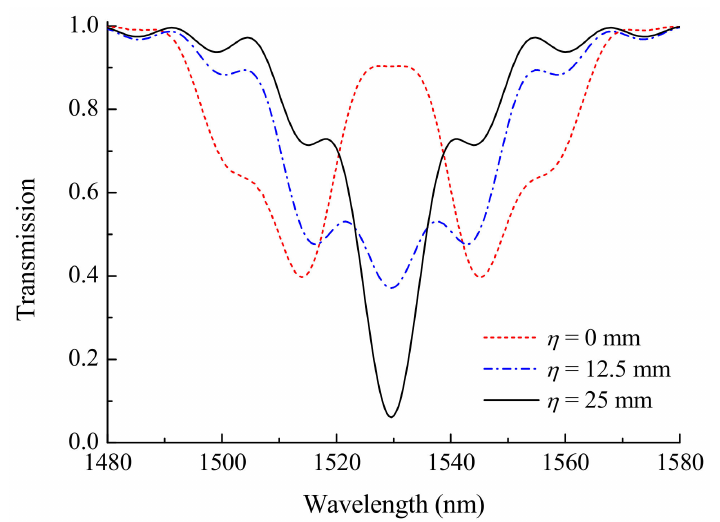
Figure 4. Transmission of grating for LP 05 cladding mode, when the acoustic front is in its center z 0 = L /2, for η = 0,12.5,and25 mm ( s 0 = 18 mstrain).